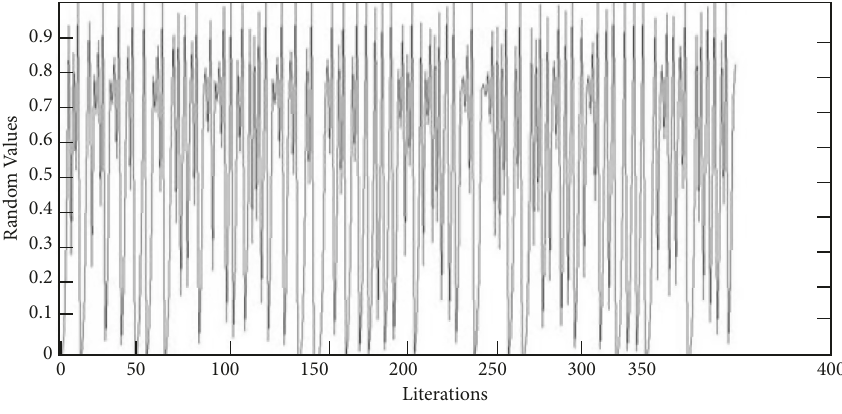
Figure 4: Behaviour of using a logistic